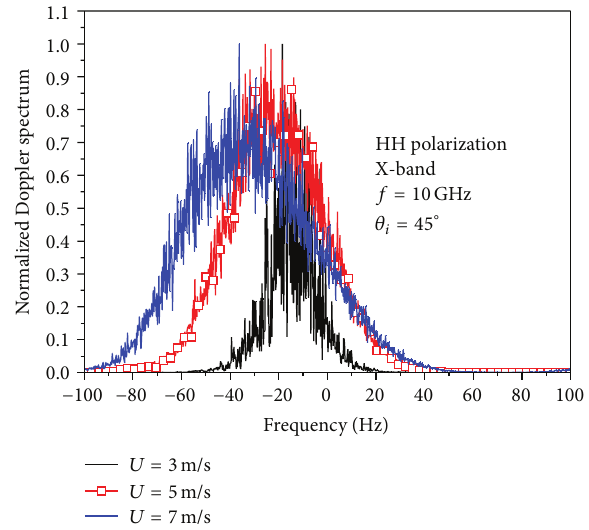
Figure 7: Doppler spectra at different wind